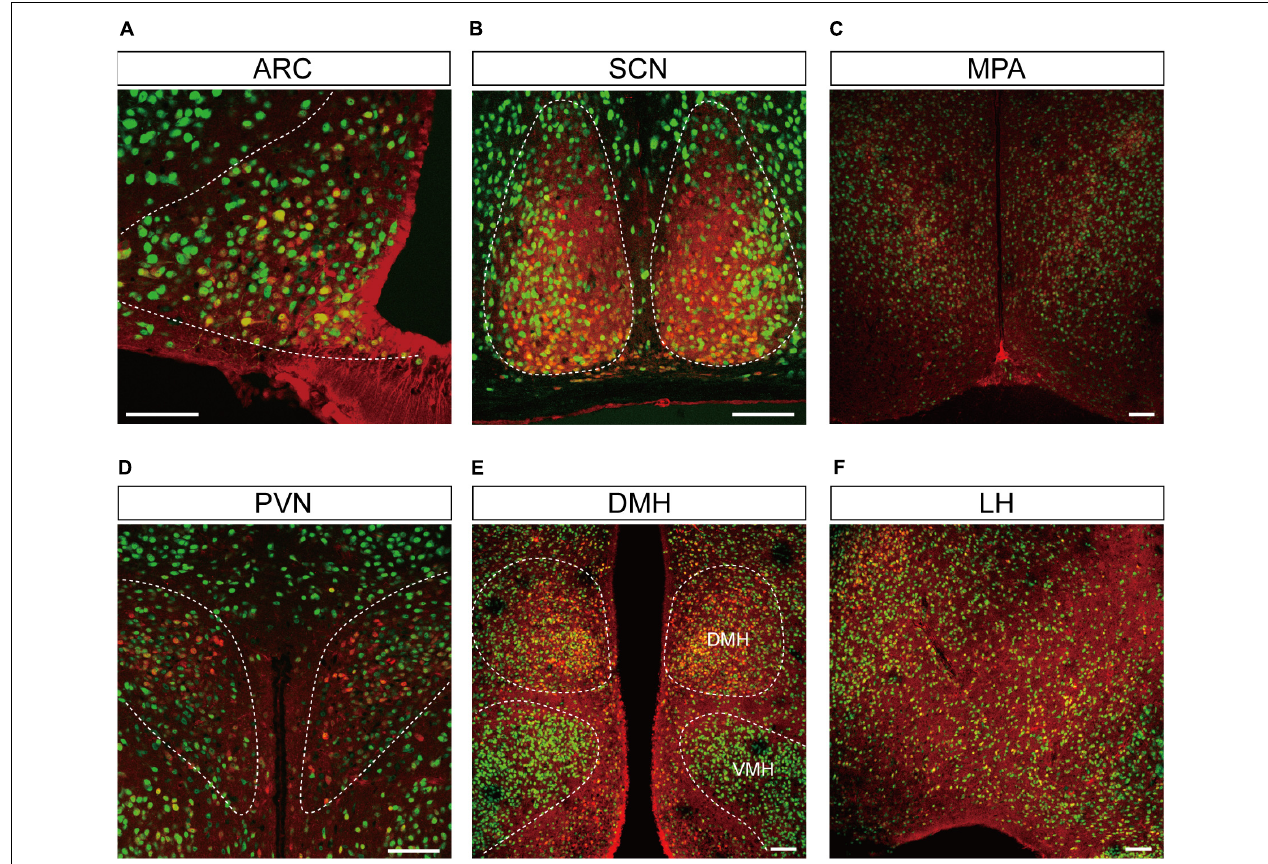
FIGURE 4 | Representative confocal images showing tdTomato fluorescence in the hypothalamic nuclei of T1r2 -tdTomato mice. (A) Arcuate nucleus (ARC), (B) suprachiasmatic nucleus (SCN), (C) median preoptic area (MPA), (D) paraventricular nucleus (PVN), (E) dorsomedial hypothalamic nucleus (DMH), and (F) Lateral hypothalmus (LH). Anti-NeuN signals (green); tdTomato (red). Scale bar, 100 µ